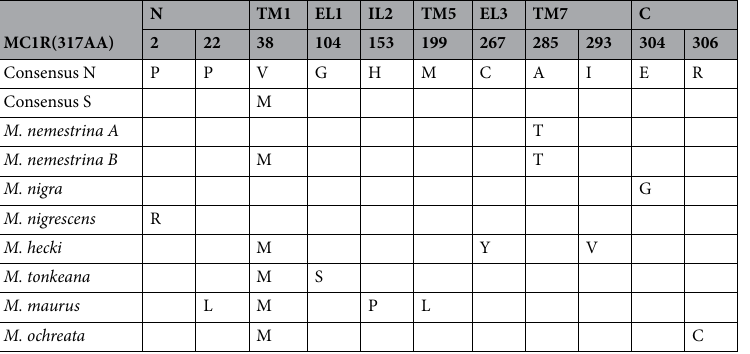
Table 1. Eleven non-synonymous substitutions in Sulwesi macaques and M. nemestrina . Ten non- synonymous substitutions were found in Sulawesi macaques and one non-synonymous substitution (A285T) was found in M. nemestrina. All substitutions were specific to a single species, except at amino acid residue 38, which showed polymorphism in M. nemestrina and shared variation between species (38V, shared by M. nigra and M. nigrescens ; 38M, shared by M. hecki. M. tonkeana, M. maurus, and M. ochreata ). N N-terminal, TM transmembrane domains, IL intracellular loop, EL extracellular loop, C C-terminal corresponds to the different MC1R domains.